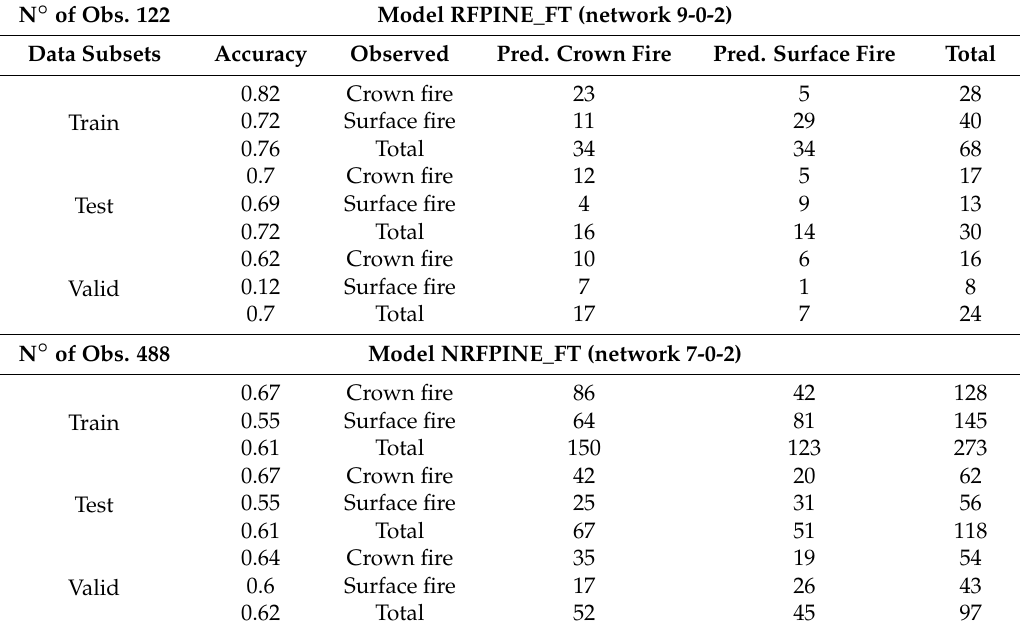
Table 6. Best model architecture and confusion matrix for the classification of Fire Type for continental Mediterranean mountain pines in reforested and natural stands. N ◦ of Obs.